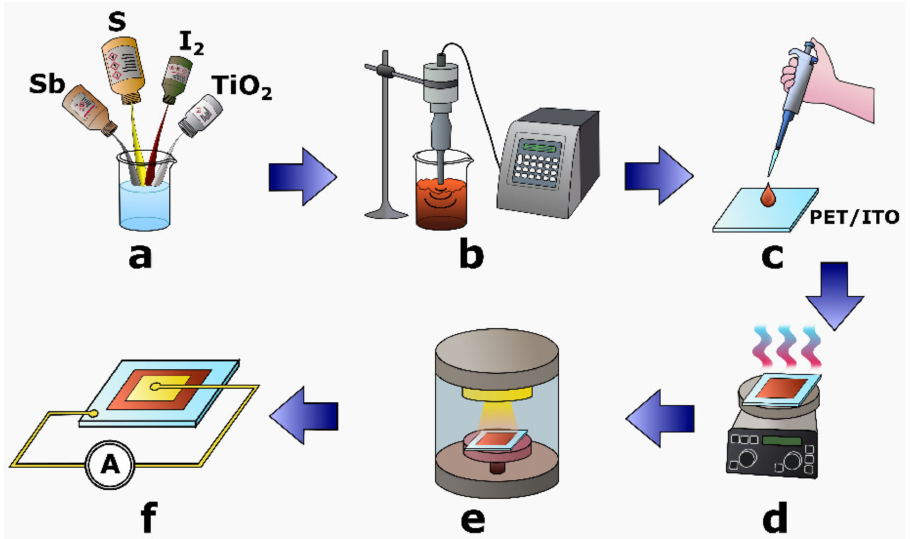
Figure 1. Schematic fabrication process flow of the SbSI–TiO 2 pyroelectric nanogenerator. A detailed description is given in the